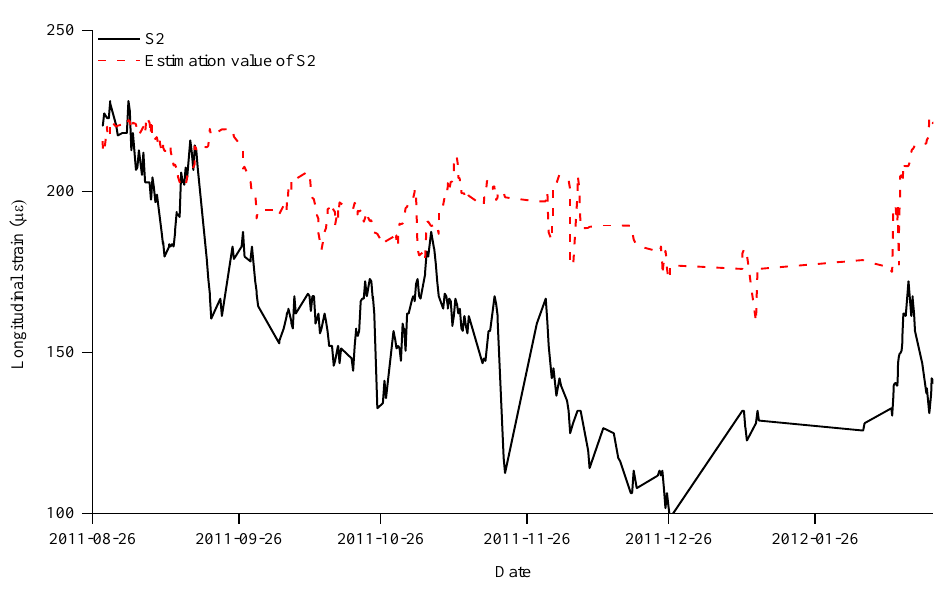
Figure 9. Estimated and measured strain data for S2 (Zone 3).